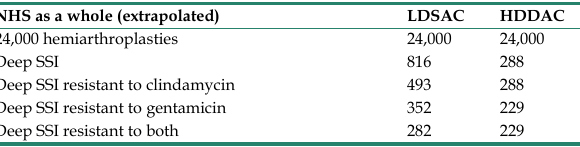
Table 5. Extrapolation of our results to a national